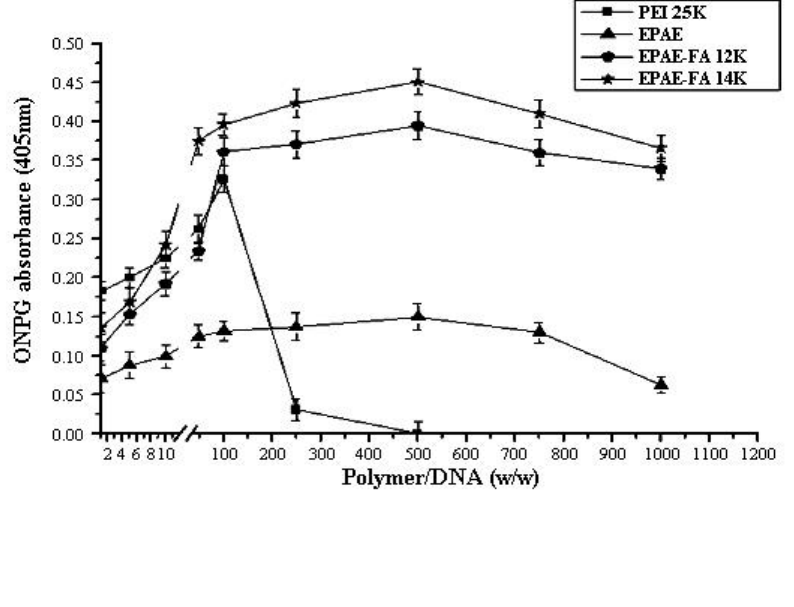
Figure 11. Transfection efficiency of the polymer/DNA complexes into cultured HeLa cells. Results are presented as the mean ± SD (n =